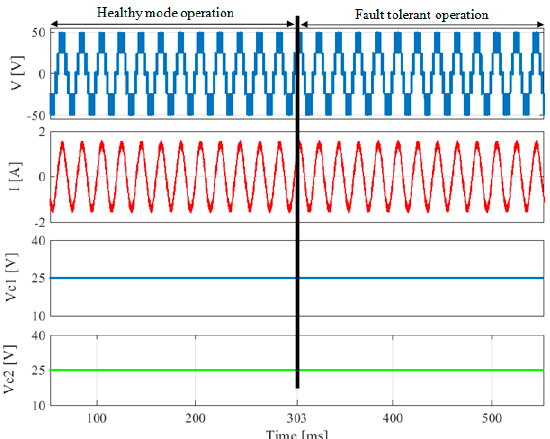
Figure 6. Simulation results of the inverter operation under open-circuit fault occurrence in S 11 , without fault-tolerant strategy.